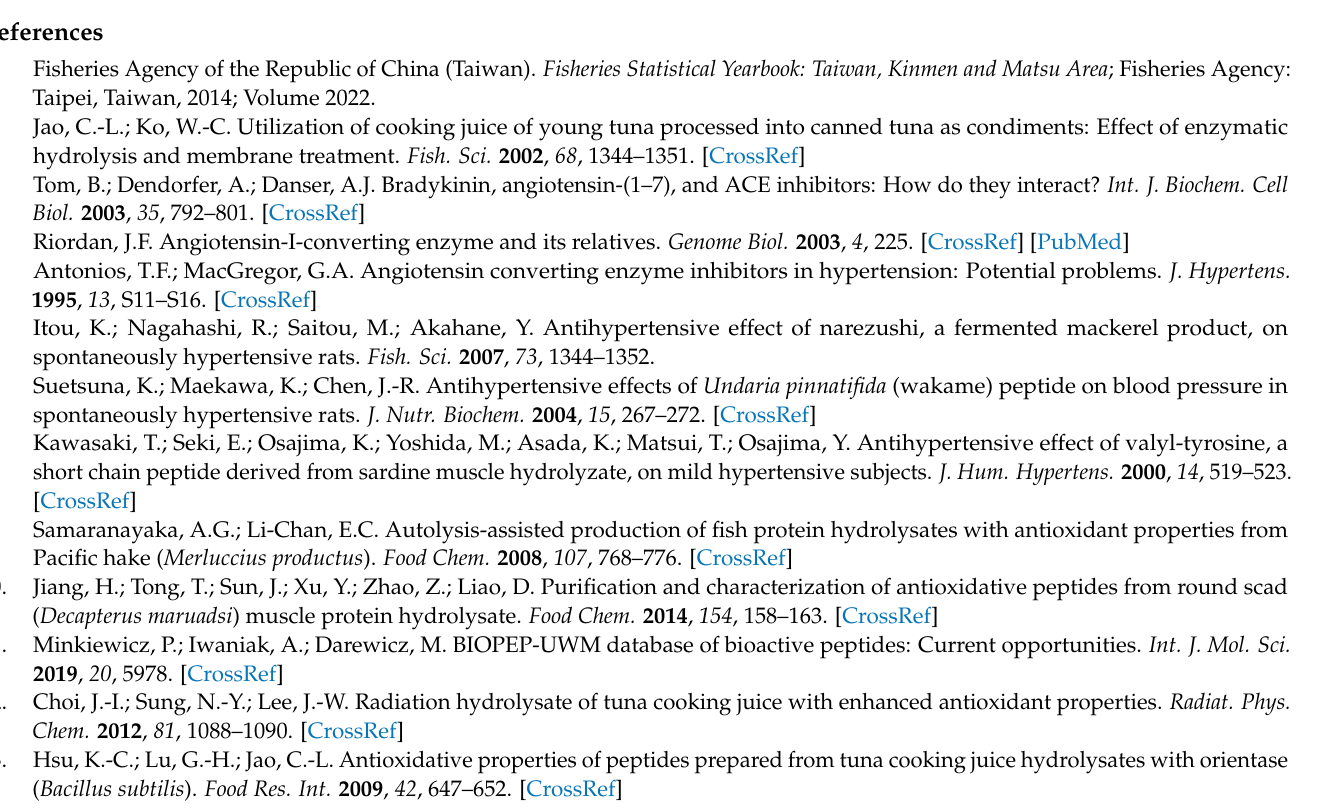
Table S1: Protein identified from mackerel steaming juice (MSJ), MSJ and mackerel meat SDS extract by SDS-PAGE and LC-MS/MS